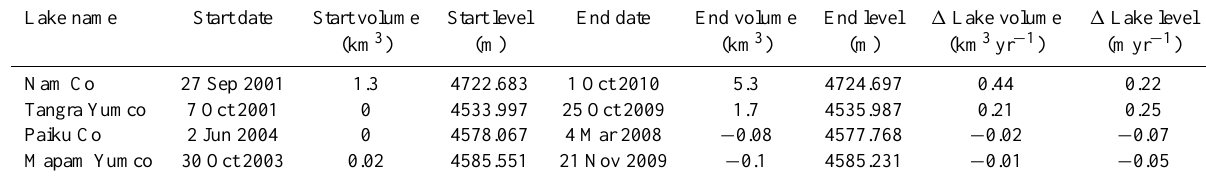
Table 2. Lake-level and water-volume changes derived from LEGOS data for the four studied lakes. Lake